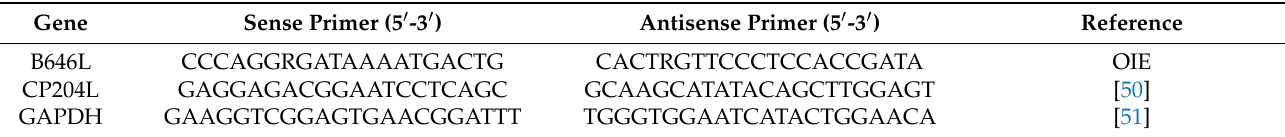
Table 1. Sequences of primers used for